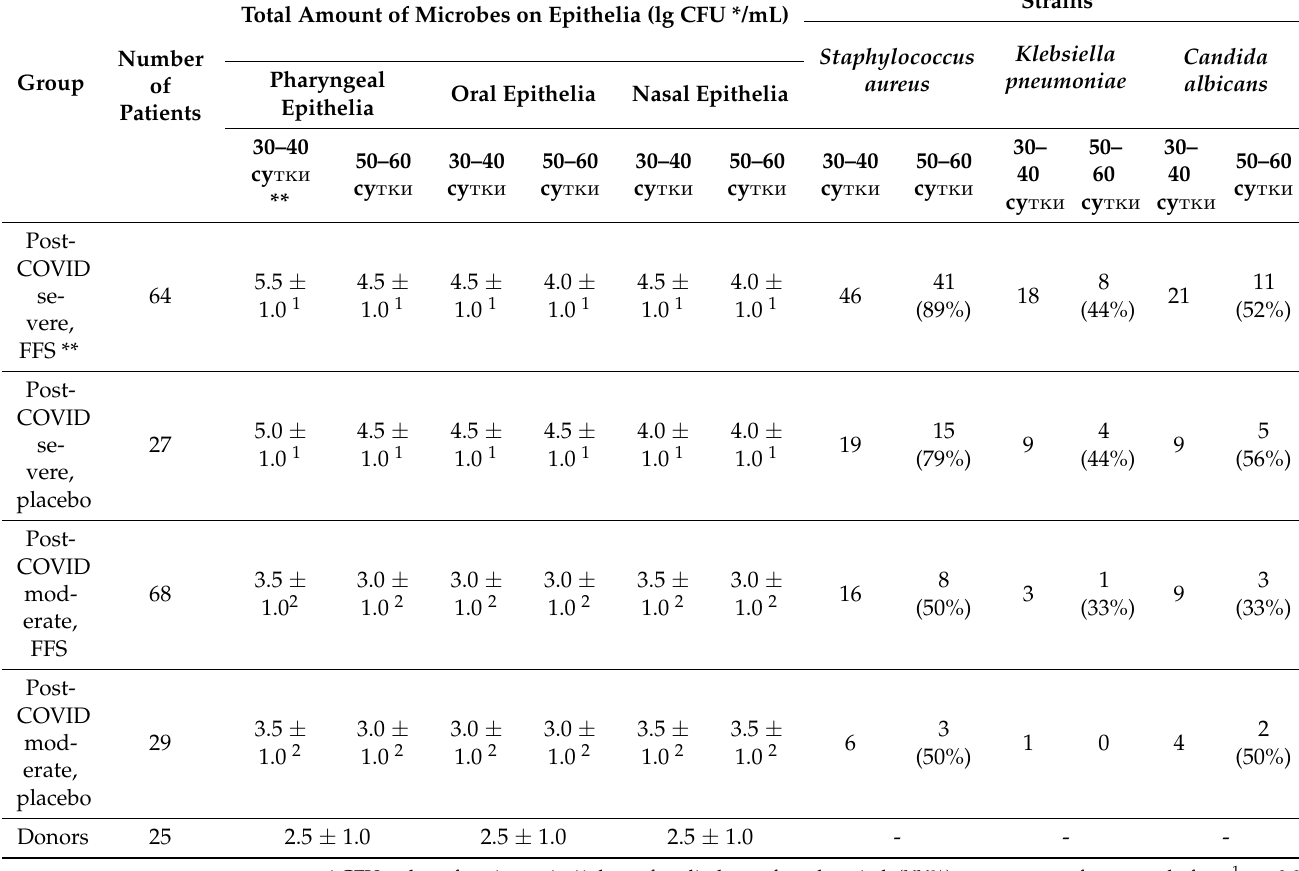
Table A1. Facultative anaerobic microbes of the oral-nasal-pharyngeal epithelia in the